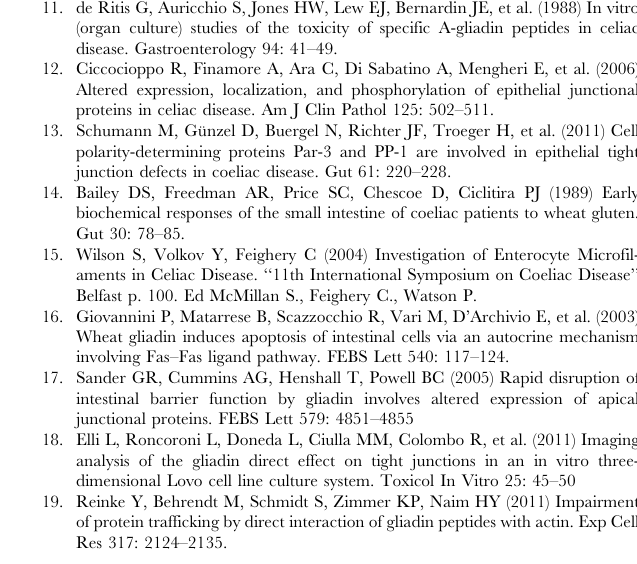
Figure S1 Costaining of FAK and actin in CD and controls fibroblasts. Confocal immunofluorescence images of fibroblasts from CD patients and controls stained with antibodies against FAK to highlight focal adhesions and Phalloidin-FITC to highlight F-actin. Representative fields of 3 independent experiments from 6 patients and 6 controls. Figure S2 LPP genotyping assay and gene expression experi- ments in CD and controls fibroblasts. A: Quantitative PCR analysis of LPP mRNA in fibroblasts from CD patients and controls. RQ = relative quantity of LPP mRNA. The round symbols and the squared symbols represented the controls and the patients respectively. Different shades of gray represented the three genotypes of LPP as in figure B. Horizontal bars and vertical bars represented the mean and the standard deviation respectively. Differences between LPP levels in patients and controls were not statistically significant (p , 0,01). Student t -test. B: Distribution of the three genotypes (AA, AC, CC) for the SNP of LPP in controls and CD subjects. In grayscale are depicted the different genotypes. The risk ‘‘A’’ alleles produced an enhanced risk and was significantly associated with CD (Izzo V, Pinelli M, Tinto N, Esposito MV, Cola A, Sperandeo MP, Tucci F, Cocozza S, Greco L, Sacchetti L. ( 2011) Improving the estimation of celiac disease sibling risk by non-HLA genes. PLoS One. 6: e26920. doi: